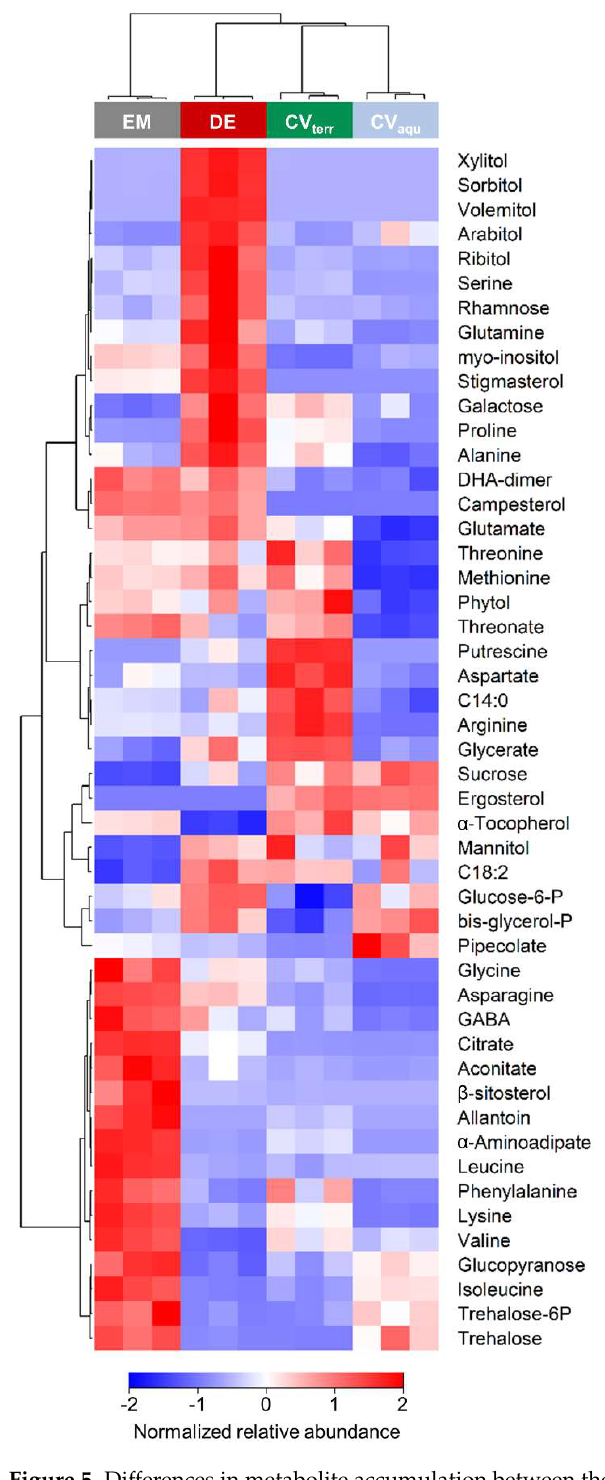
Figure 5. Differences in metabolite accumulation between the four algal strains. The heatmap shows a comparison of untreated algae; colours from dark to light blue, via white, to light to dark red denote low to high relative abundances. Colour code on top: grey, blue, red, and green denote Edaphochlorella mirabilis (EM), the aquatic strain of Chlorella vulgaris (CV aqu ), Diplosphaera epiphytica (DE), and the terrestrial strain of Chlorella vulgaris (CV terr ), respectively, according to one-way ANOVA p -value < 0.01 after FDR correction, max log 2 ratio >1.